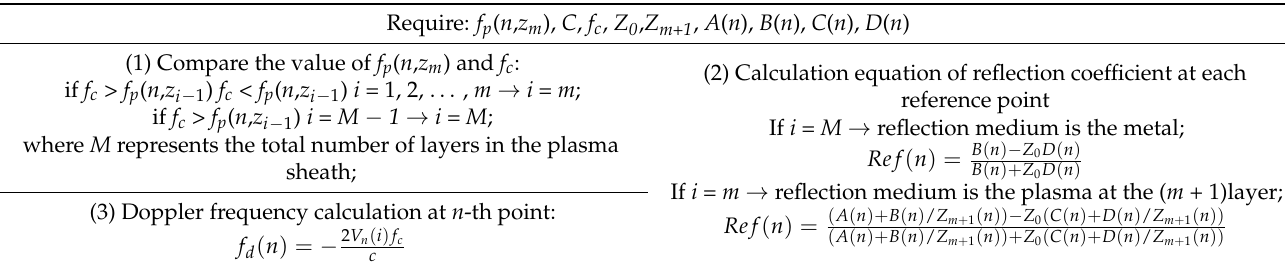
Table 1. Reflection coefficient and IaD-frequency calculation